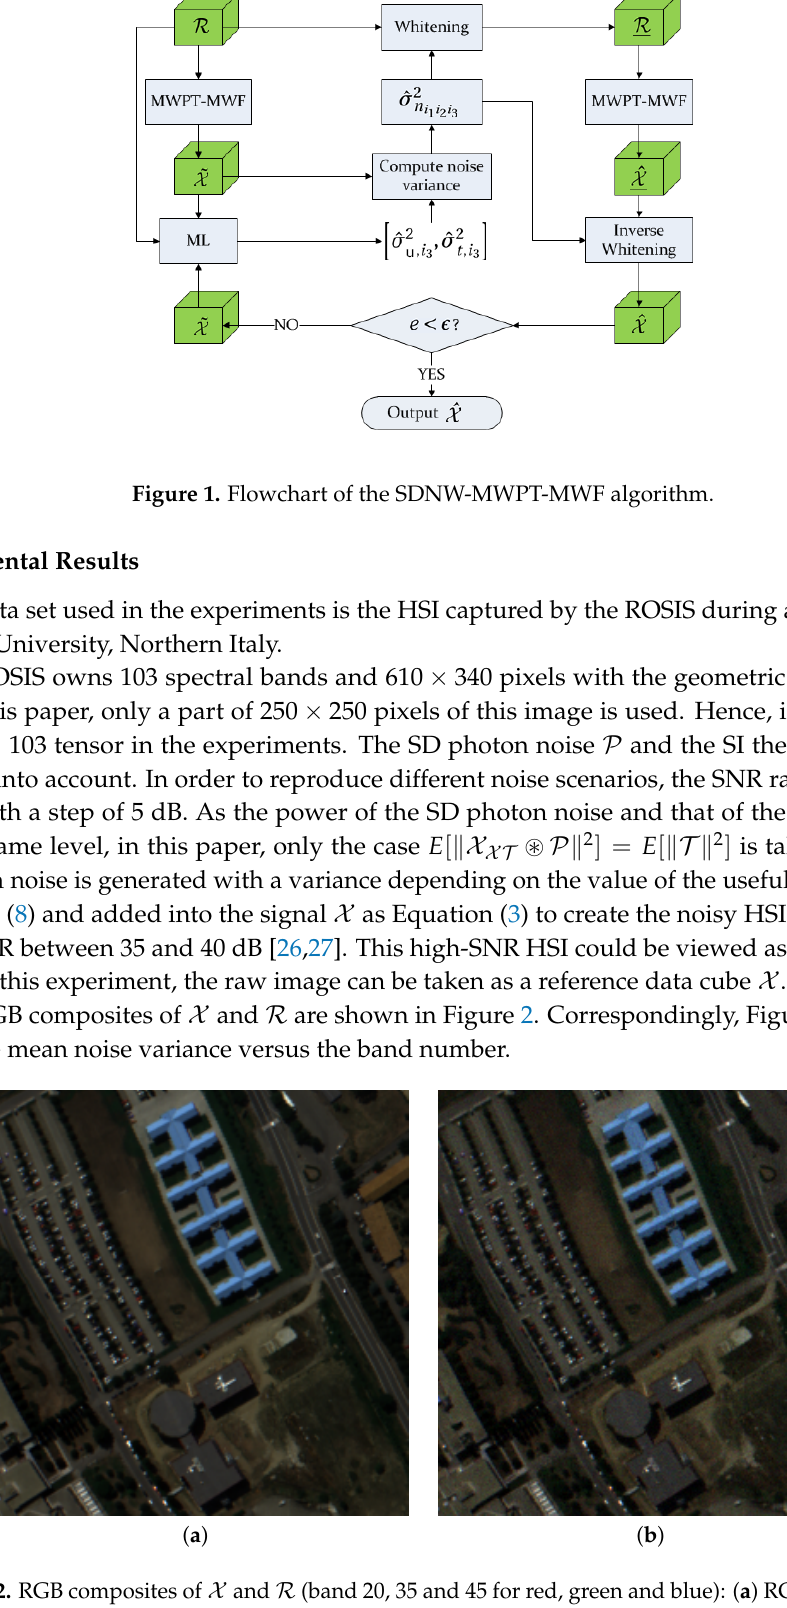
Figure 2. RGB composites of X and R (band 20, 35 and 45 for red, green and blue): ( a ) RGB composites of X ; ( b ) RGB composites of R